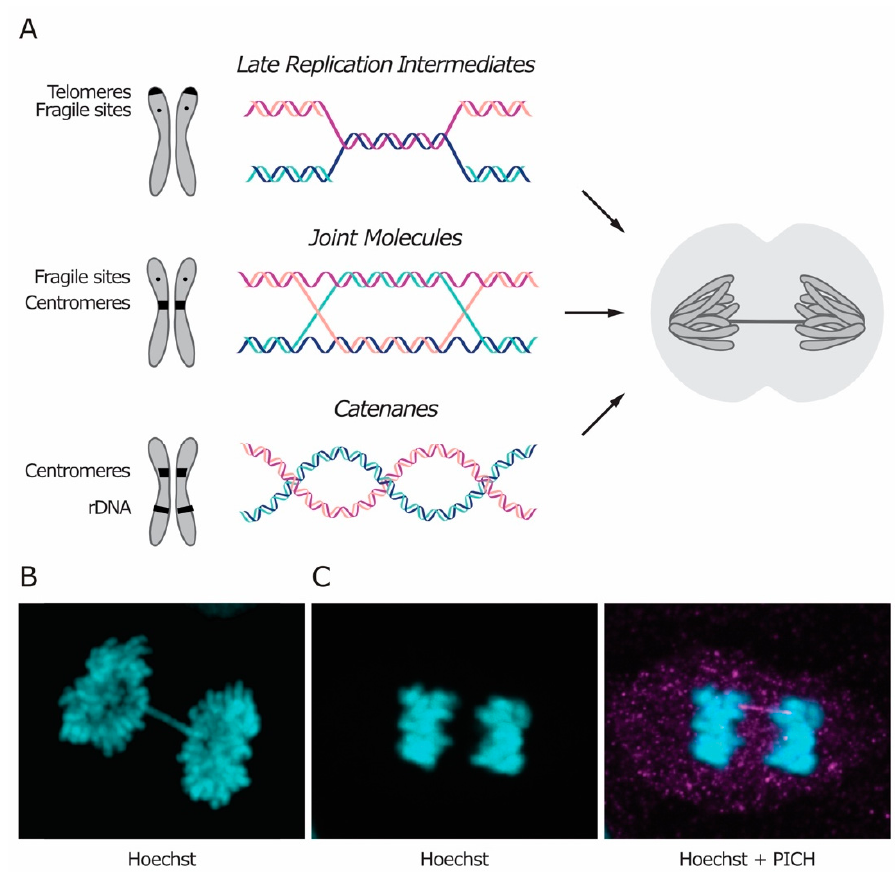
Figure 1. Three types of sister chromatid intertwines (SCIs) are observed during mitosis. ( A ) Molecular structures of late replication intermediates, joint molecules (here exemplified by a double Holliday junction) and catenanes are shown. Genomic loci at which each type of SCI were observed are indicated in the schematic chromosomes. The consequence of persistent SCIs in mitosis – a.k.a. anaphase bridges – is shown in the drawn cell. ( B , C ) Representative images of ( B ) a chromatin bridge and ( C ) an ultra-fine bridge are shown in retinal pigment epithelium (RPE-1) cells. DNA-intercalating dye Hoechst in cyan, Plk1-interacting checkpoint helicase (PICH) in magenta. Courtesy images by Neal Umbreit ( B ) and Mitchell Leibowitz ( C ).